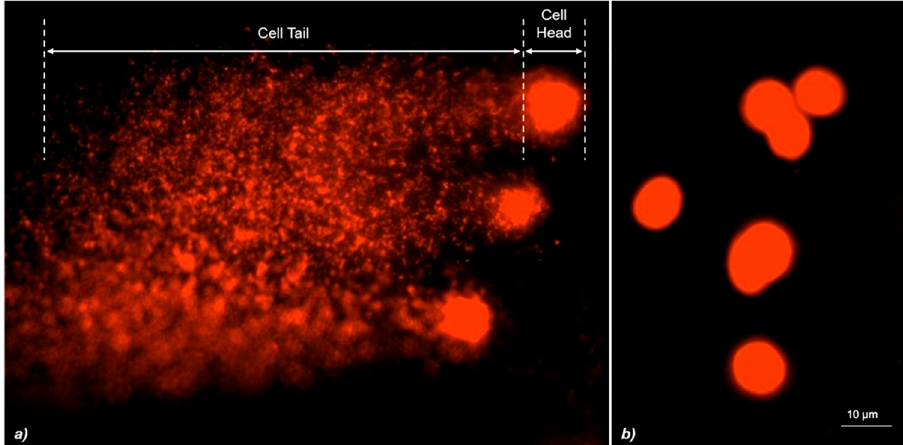
Figure 3. ( a ) Comet tail DNA in zebrafish blood cells analyzed using Komet software. ( b ) Undamaged zebrafish blood cells analyzed using Komet software.